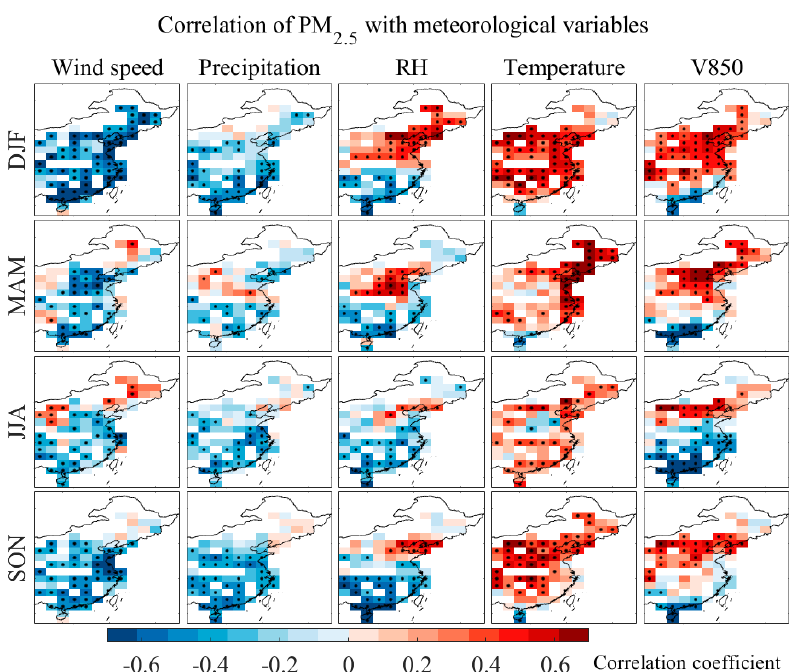
Figure 4. Correlation coefficients ( r ) of PM 2 . 5 concentration with the individual meteorological variables used in the MLR model: surface wind speed (ms − 1 ), precipitation (mmd − 1 ), relative humidity (RH; %), surface air temperature ( ◦ C), and 850hPa meridional wind velocity (ms − 1 ) for different seasons in China. The correlations are based on 10d average observations on a 2 ◦ × 2.5 ◦ grid. Dots indicate statistically significant correlations ( p < 0 . 05).